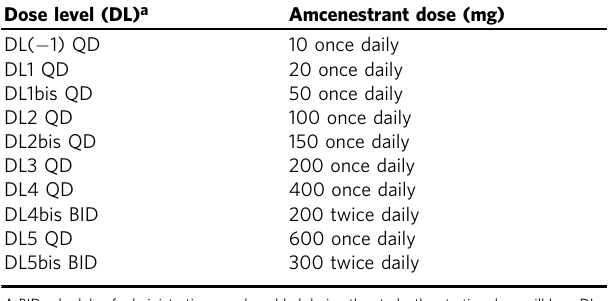
Table 1 Pre-speci fi ed dose-escalation schedule for amcenestrant monotherapy in Part